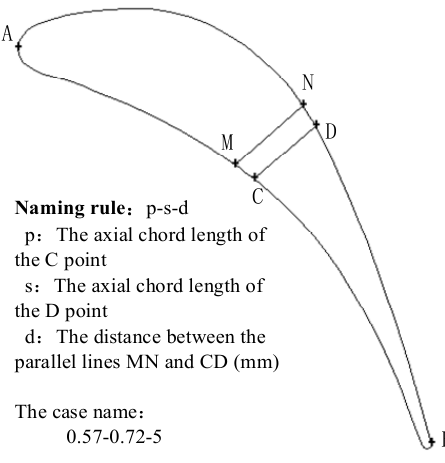
Figure 3. Naming rule.